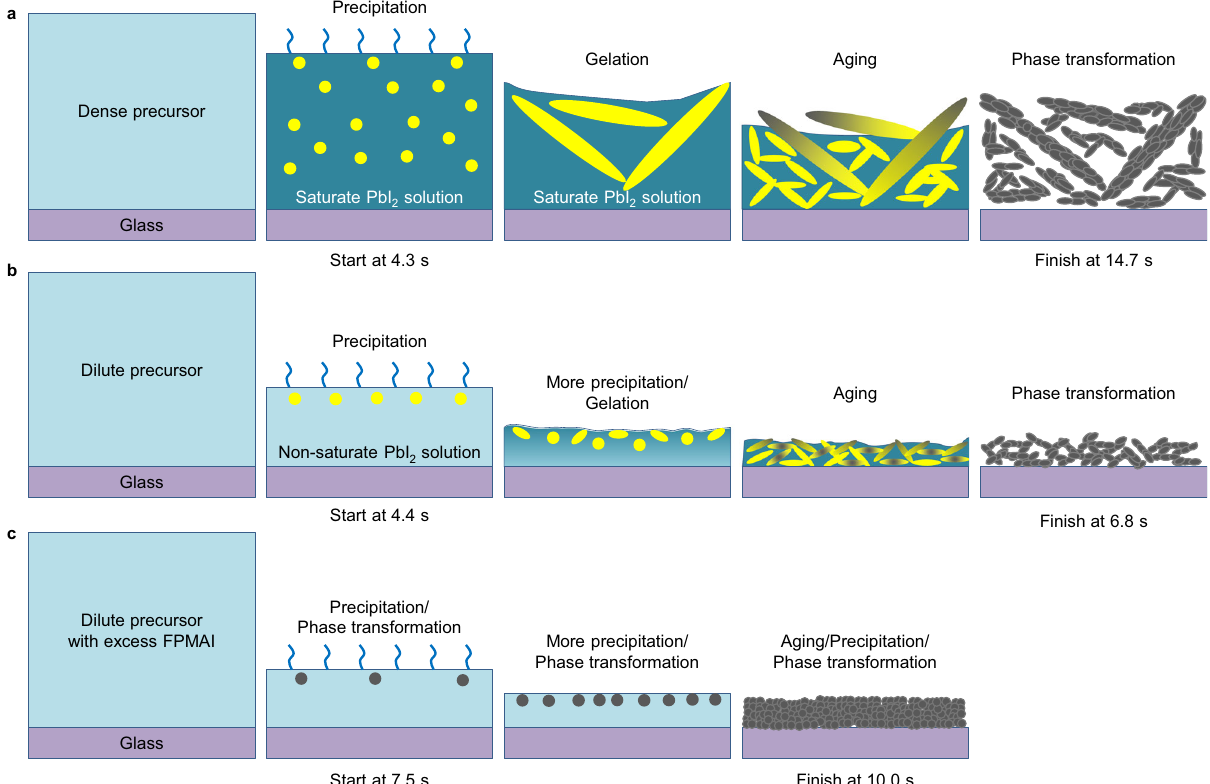
Fig. 2 Schematics of sol – gel stages for different blade-coating methods. a – c Schematics of the sol – gel stages using a dense precursor solution (0.8 M) ( a ), a dilute precursor solution (0.2 M) ( b ), and a dilute precursor solution with 50% molar excess FPMAI ( c ). All schematics are drawn according to the in situ optical microscopic images and the videos (Supplementary Fig. 5 and Movies) of the fi lm formation processes without N 2 knife. The fi lm formation process with N 2 knife or using dilute solutions with concentration <0.2 M are too fast to be resolved by optical microscope. The timing for precipitation beginning and phase transformation ending are also marked below the